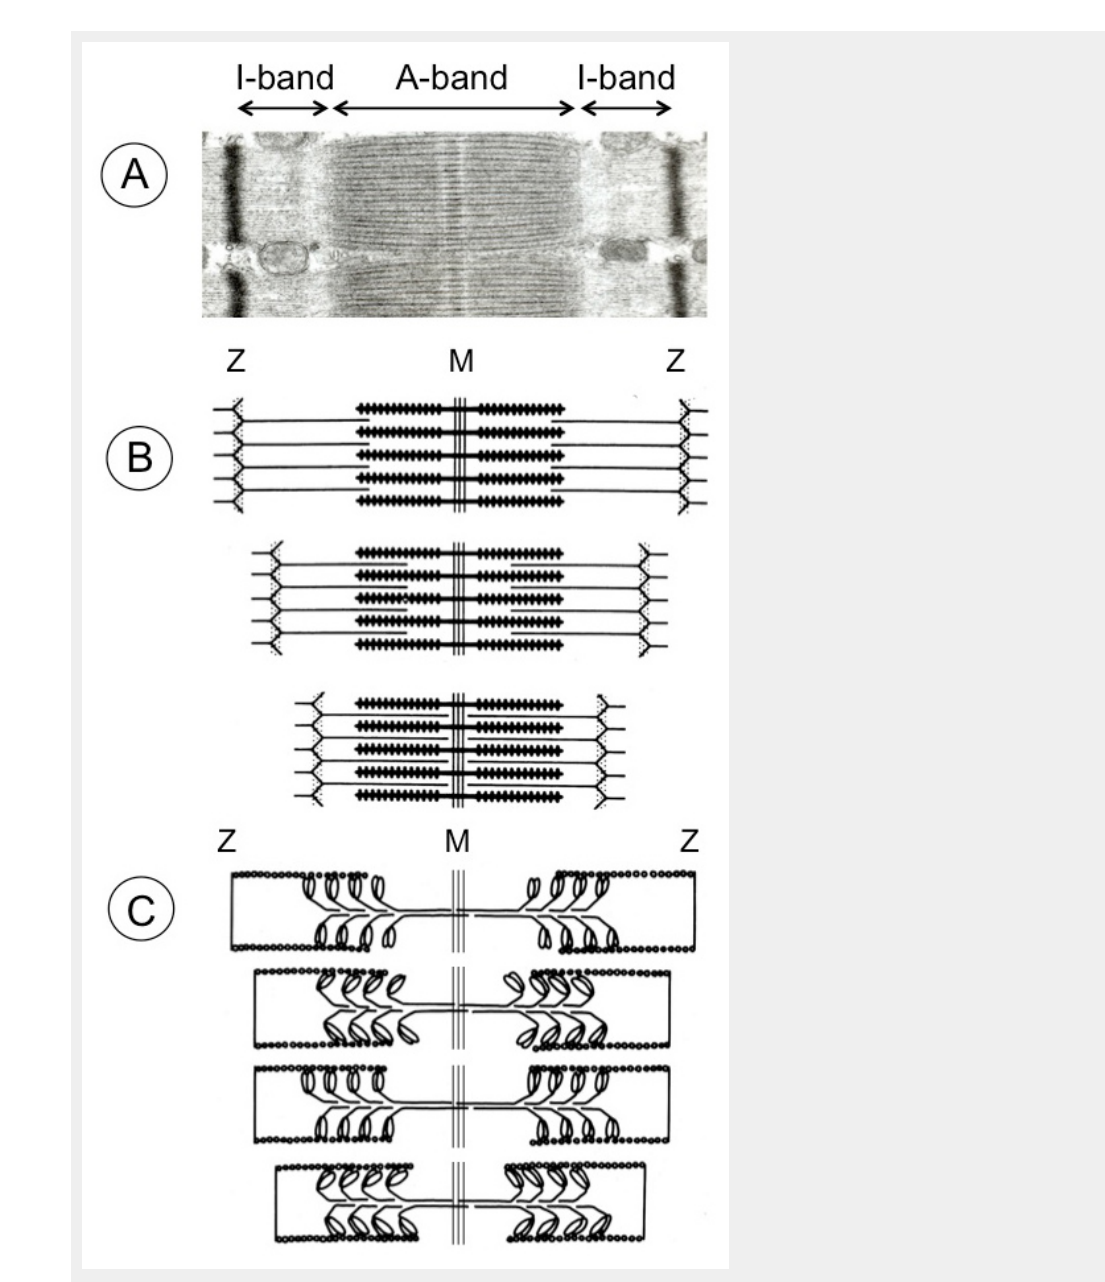
Figure 1 Sarcomere shortening of mammalian skeletal muscle. (A) Electron micrograph of sarcomere displaying A-band (anisotropic) consisting of myosin thick filaments with the interdigitating actin filaments and the M-band proteins in the middle. The I-band (isotropic) contains the thin actin filaments reaching from the Z-discs (black) toward the A-band. The third filamentous structure (not visible in the graph) consists of the giant protein titin. Each titin molecule extends from the sarcomere middle over half the sarcomere length to the Z-disc. Several dozens additional proteins are associated with the three major structural proteins. (B) During muscle contraction the sarcomeres shorten by sliding of the actin filaments toward the sarcomere center while the myosin and actin filaments preserve their original length. (C) The sliding of the two filamentous systems is brought about by repetitive fixation of the myosin heads (crossbridges) at actin, bending toward the sarcomere middle, followed by detachment and fixation again in a new position. This cyclic movement of the myosin heads is coupled to ATP hydrolysis that provides the energy. In reality the myosin heads are not moving in concert like the athletes in a rowing boat (as depicted in (C)) but are moving irregularly